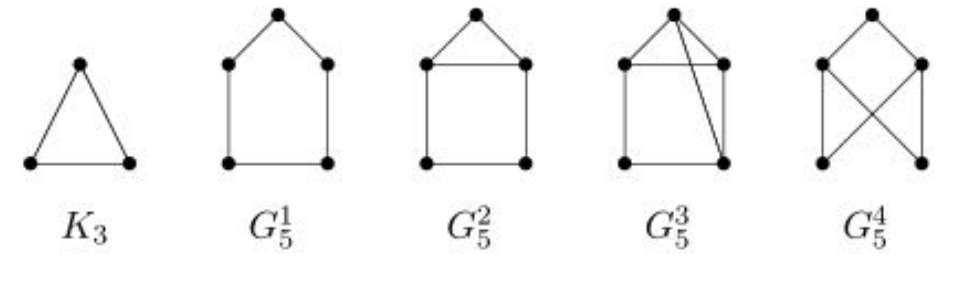
Figure 1. Graphs in family A .